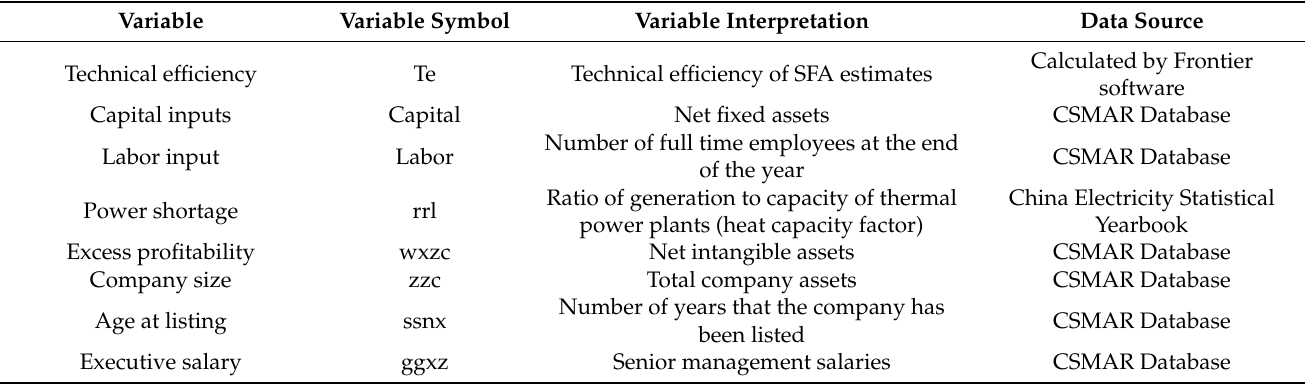
Table 1. Variable interpretation and